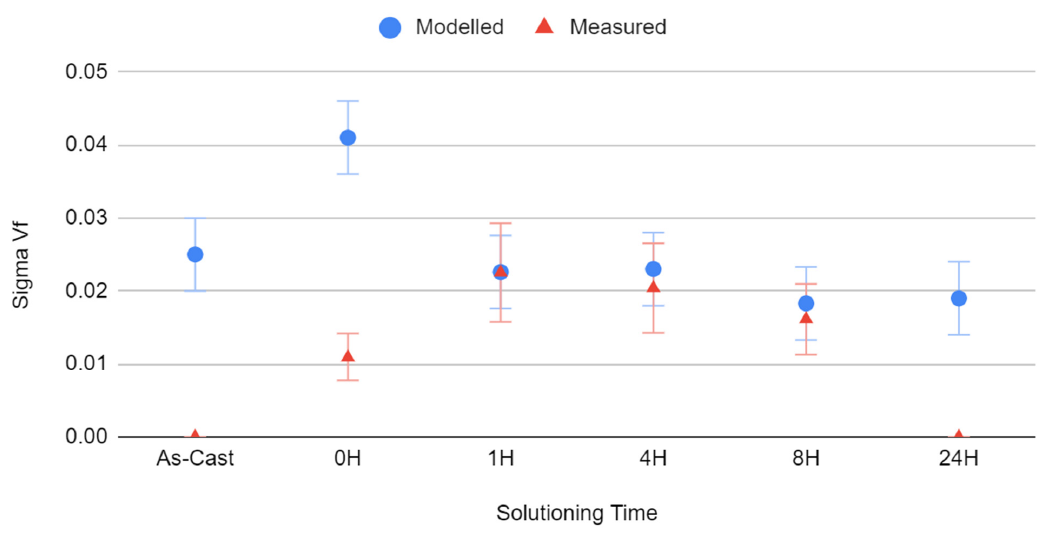
Figure 3. The calculated values of σ -phase volume fraction (Vf) using different methods for CMSX- 10K. CMSX-10K.